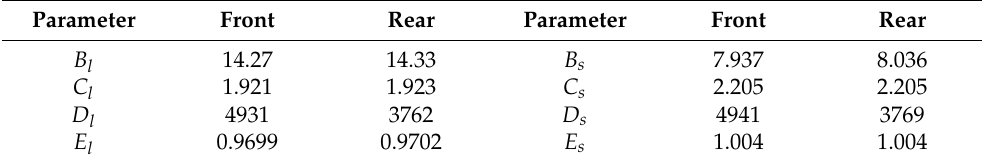
Table 2. Parameters of tire force.